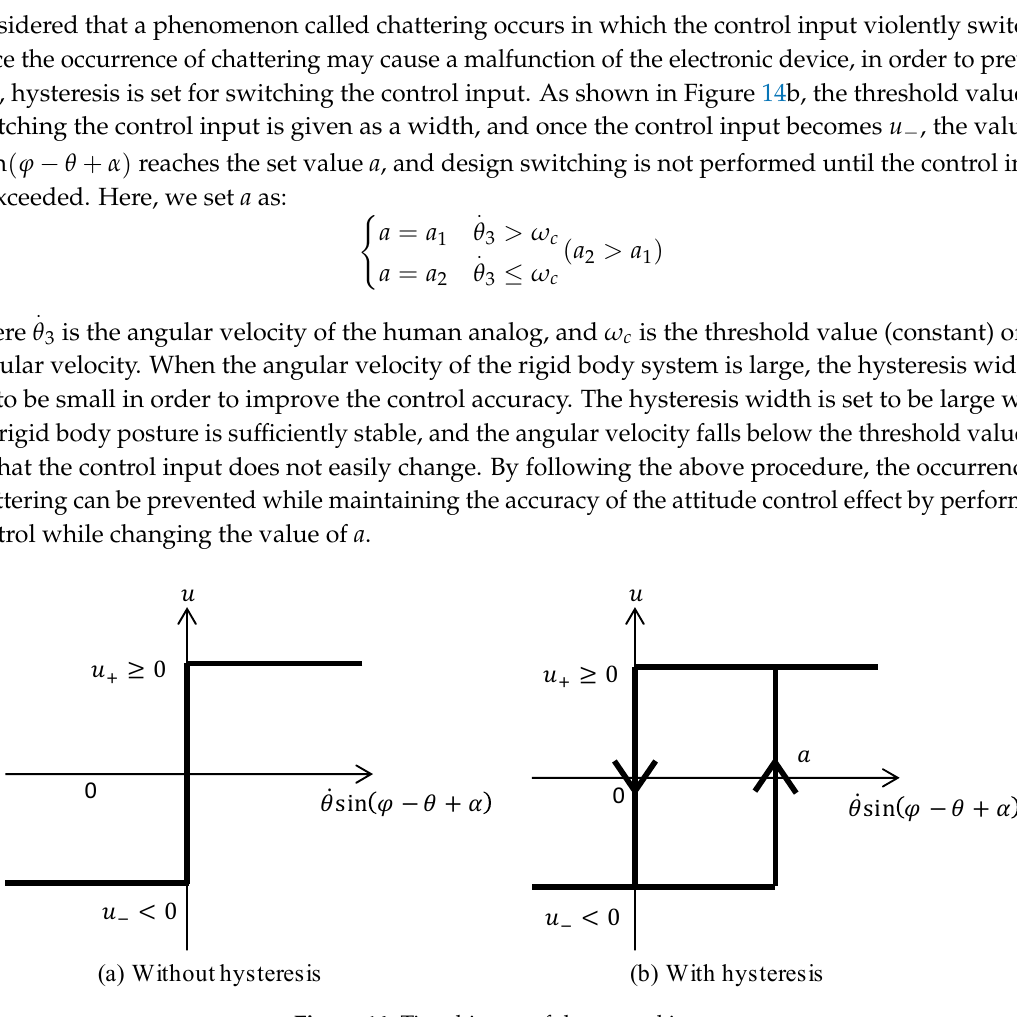
Figure 14. Time history of the control input.